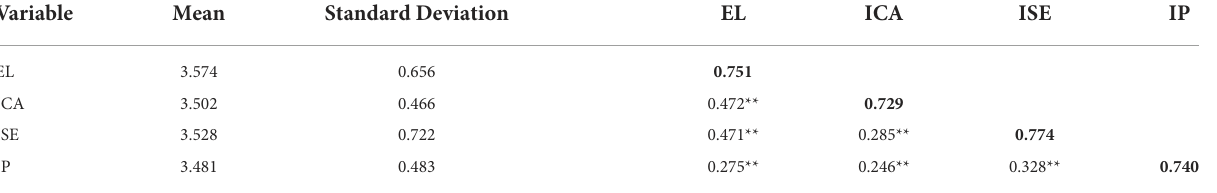
TABLE 3 Means, standard deviation, and correlation coefficients of the variables.